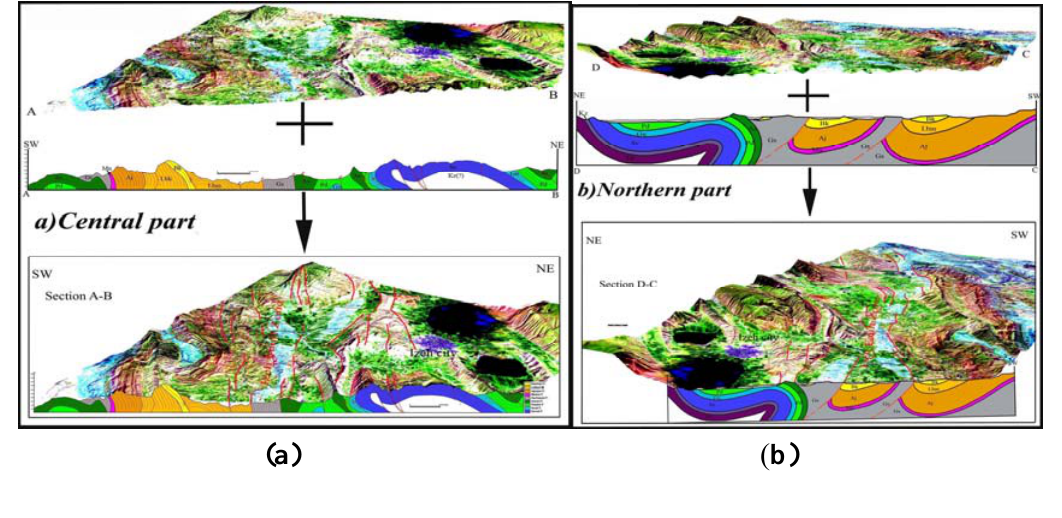
Figure 5. The different stages for 3D sketches generation: (a) The geometric corrected Landsat ETM+ satellite image overlaid on DEM; (b) surveyed cross sections in opposite